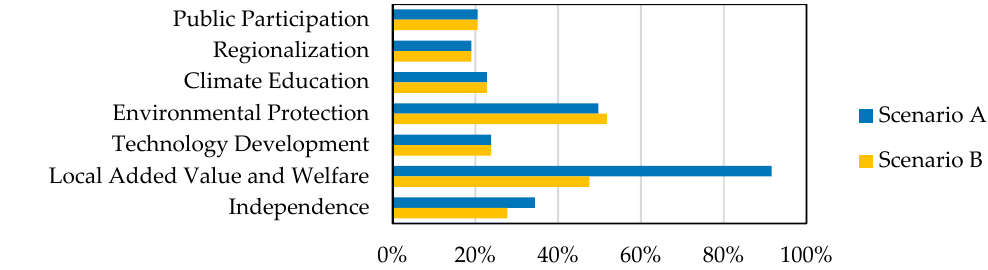
Figure 6. Unweighted degree of objective achievement 𝑥⃗ (cid:3002) and 𝑥⃗ (cid:3003) for Scenarios A and B.